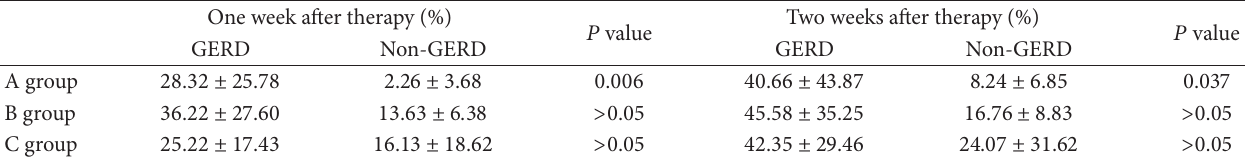
Table 4: Comparison of improving SF-36 rate between GERD and non-GERD patients after one-week and two-week therapy.